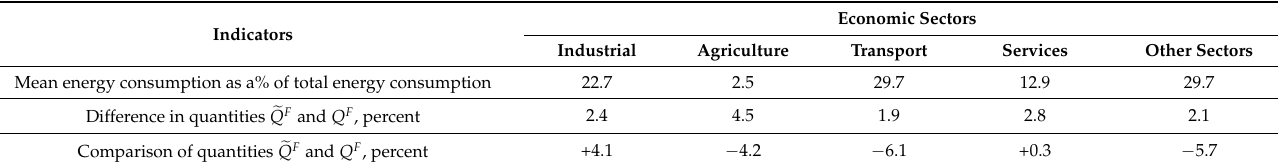
Table 3. Comparison of the current and transformed values representing sectoral energy development in the targeted European countries over the 2009–2018 period (source: compiled by the authors).